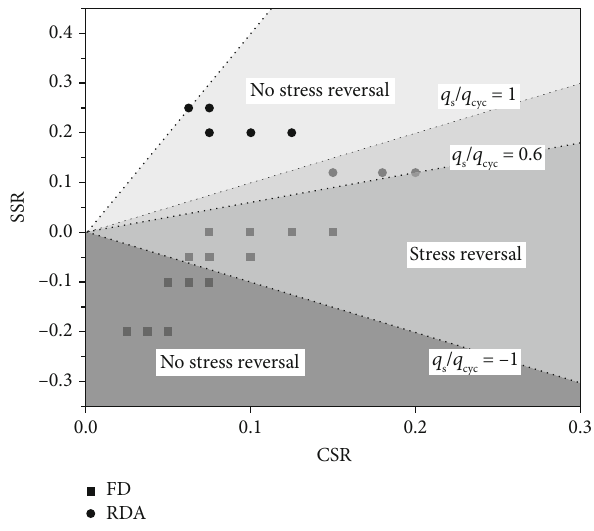
Figure 7: Summary of loose sand behavior types under di ff erent stress